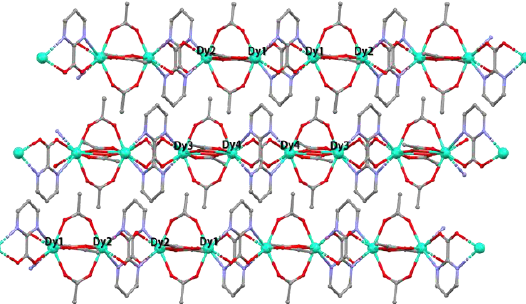
Figure 2. Perspective view along the b-axis of the two independent two-dimensional layers present in compound 1 .